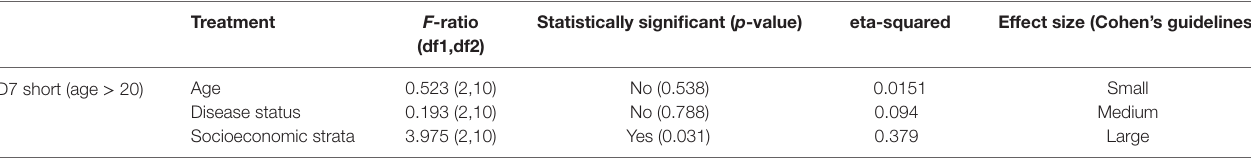
TaBle 2 | Analysis of variance table showing the test statistics F -ratio, statistical significance with α = 0.05, and effect size reported for each variable (age, disease status, and living conditions) evaluated in D7 short excluding age group 1 (participants under 20 years old).